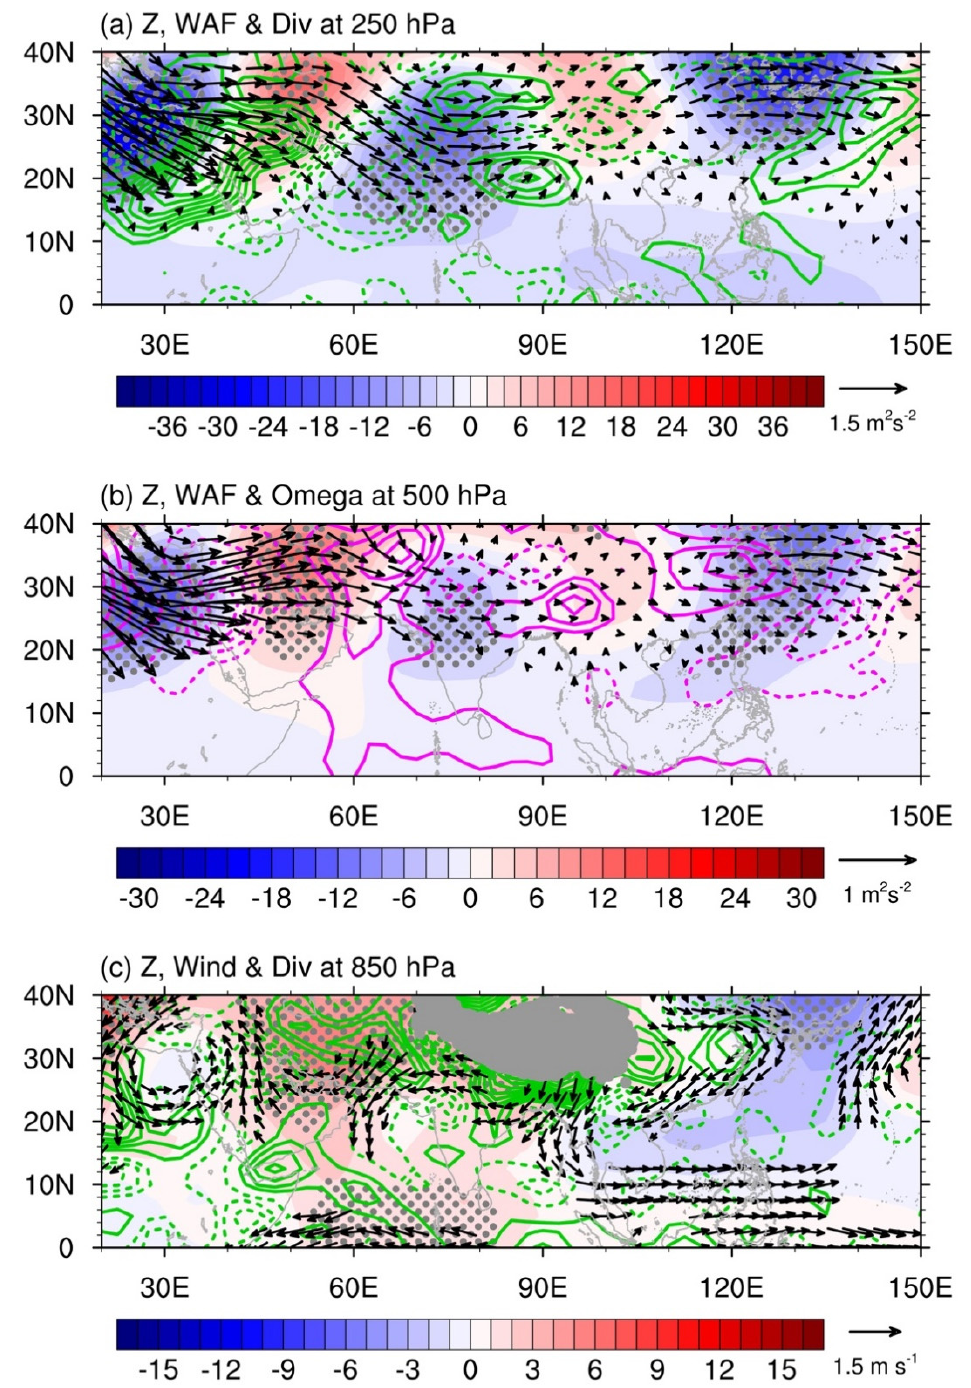
Figure 5. ( a ) Geopotential height anomalies (shading, unit: gpm), wave activity flux (vector, unit: m 2 s − 2 ), and divergence (green contour, CI = 0.02 × 10 − 5 s − 1 ) at 200 hPa in May regressed onto the normalized time series of PC1; ( b ) geopotential height anomalies, wave activity flux, and omega (purple contour, CI = 0.004 Pa s − 1 ) at 500 hPa in May regressed onto the normalized time series of PC1; ( c ) geopotential height anomalies, wind (vectors, unit: m s − 1 ), and divergence (green contour, CI = 0.015 × 10 − 5 s − 1 ) at 850 hPa in May regressed onto the normalized time series of PC1. All zero contours are omitted, and the solid (dashed) contours indicate the positive (negative) values. Dotted areas indicate that the regression coefficients of geopotential height anomalies are significant at the 95% confidence level. The grey shading area is the plateaus in ( c